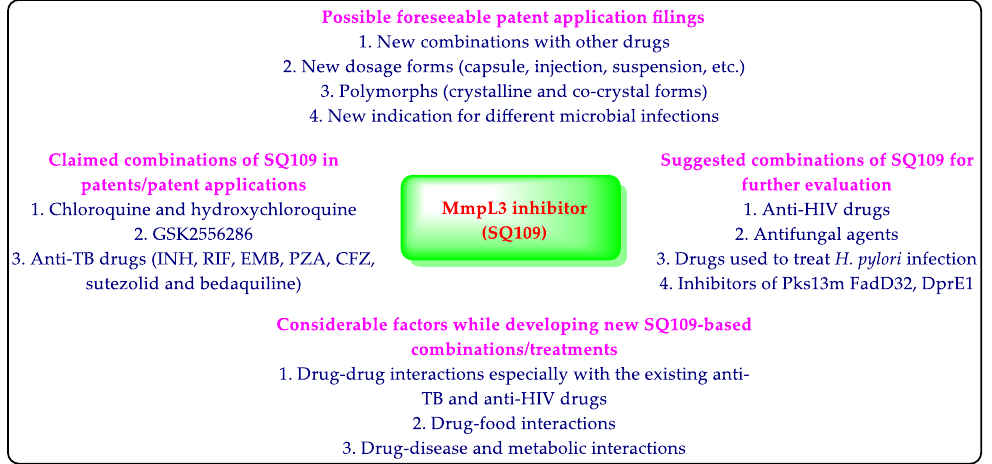
Figure 4. Summary and suggestions for the SQ109 -based work.